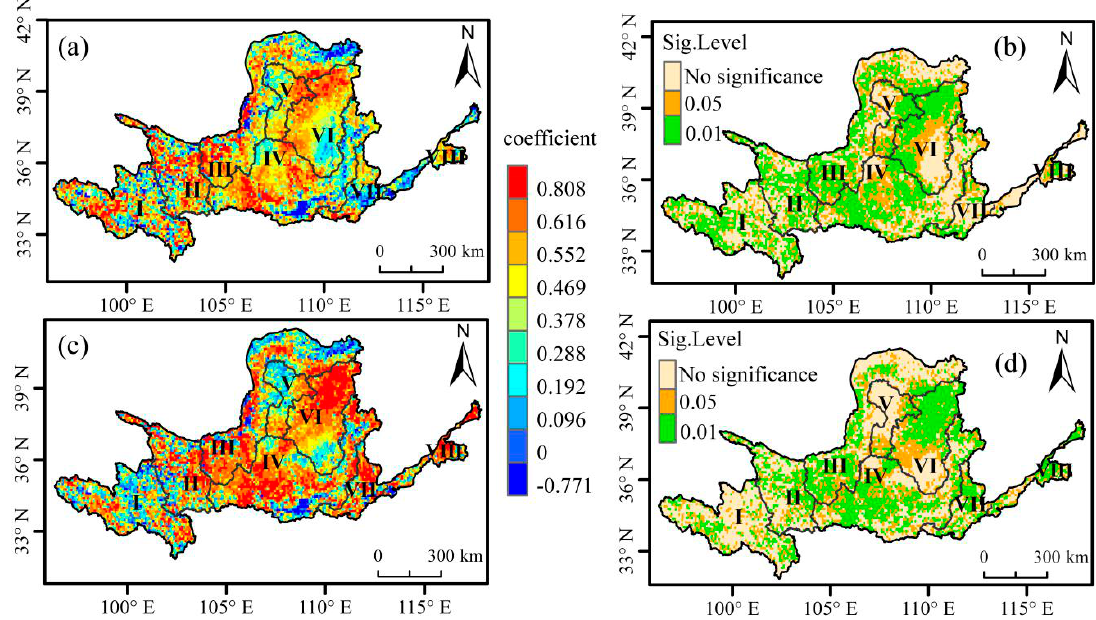
Figure 4. Spatial patterns of the correlations between Normalized Di ff erence Vegetation Index (NDVI) and T max or T min during the growing season (April–October) in the Yellow River Basin, 1982–2015. ( a ) Mapping of the partial correlation coe ffi cients between NDVI and T max , given that the corresponding T min and precipitation are controlled for in the calculation. ( b ) Spatial distribution of significance level of the partial correlation coe ffi cients between NDVI and T max . ( c ) The partial correlation coe ffi cients between NDVI and T min by controlling T max and precipitation. ( d ) Spatial distribution of partial correlation coe ffi cients between NDVI and T min .(I: Longyangxia in the upper reaches; II: Longyangxia to Lanzhou; III: Lanzhou to Hekou town; IV: Longmen to Sanmenxia; V: Inflow zone; VI: Hekou town to Longmen area; VII: Longmen to Huayuankou; VIII: below Huayuankou in the lower